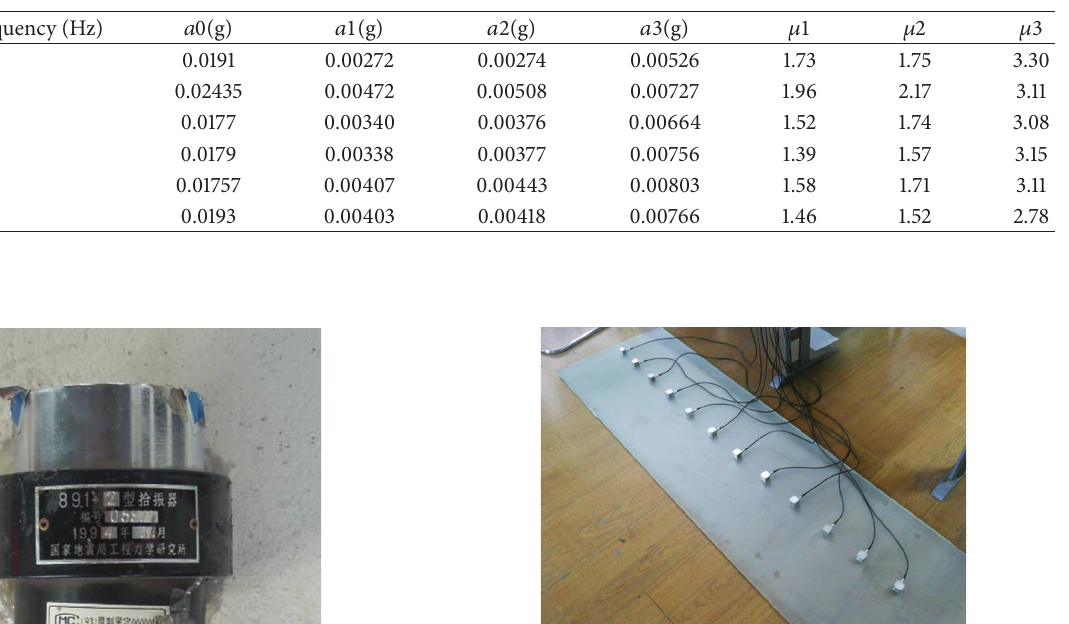
Table 7: Extreme and enhanced coefficient of acceleration response (0.02 g).